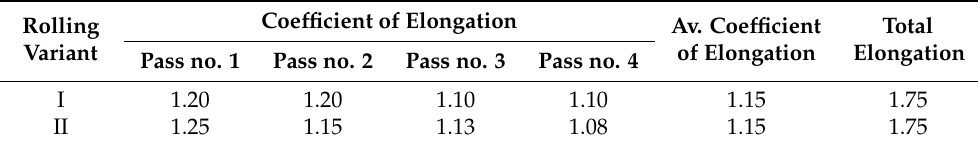
Table 2. Pattern of deformations used in the rolling process of Mg/Al bimetallic bars. Rolling